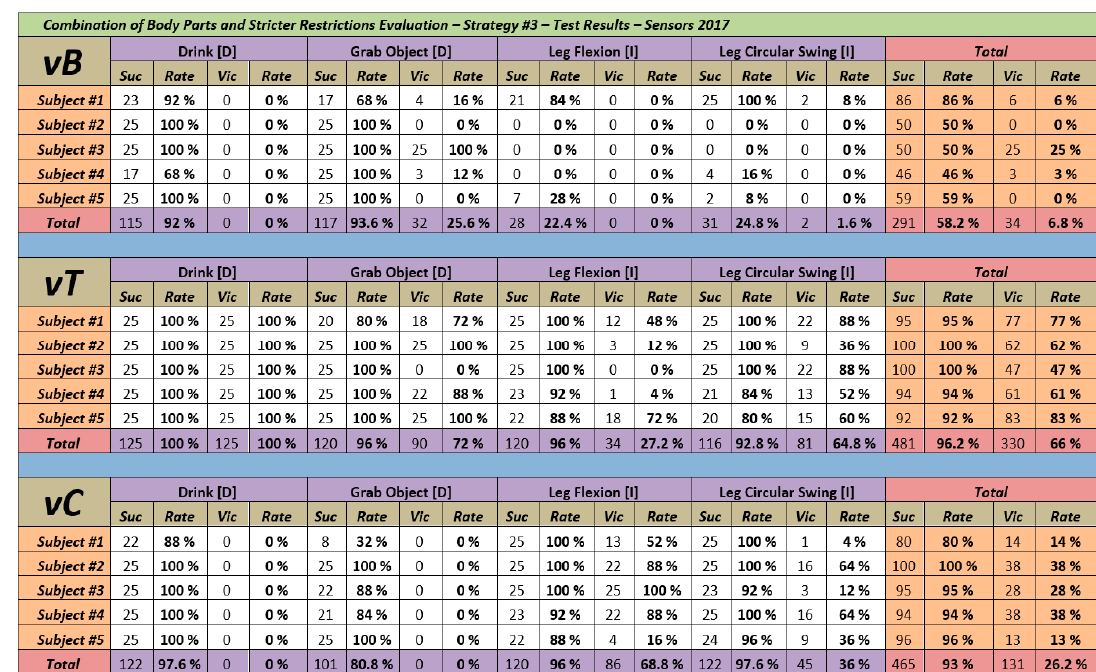
Figure 7. Combination of Body Parts and Stricter Limits Evaluation Results.